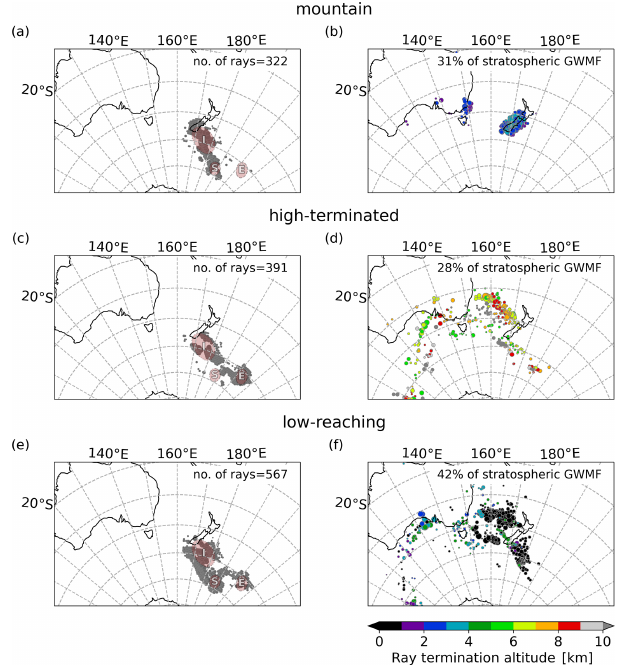
Figure 4. Ray tracing results for (a, b) mountain, (c, d) high- terminated, and (e, f) low-reaching ray categories. (b, d, f) The lo- cation of the ray termination for different source categories. The colour of the markers shows the lowest ray altitude. The percent- age of the stratospheric GWMF is stated in the upper right corner of each panel. (a, c, e) Location of the ray launch points at 25km altitude. The number of rays is stated in the upper right corner of each